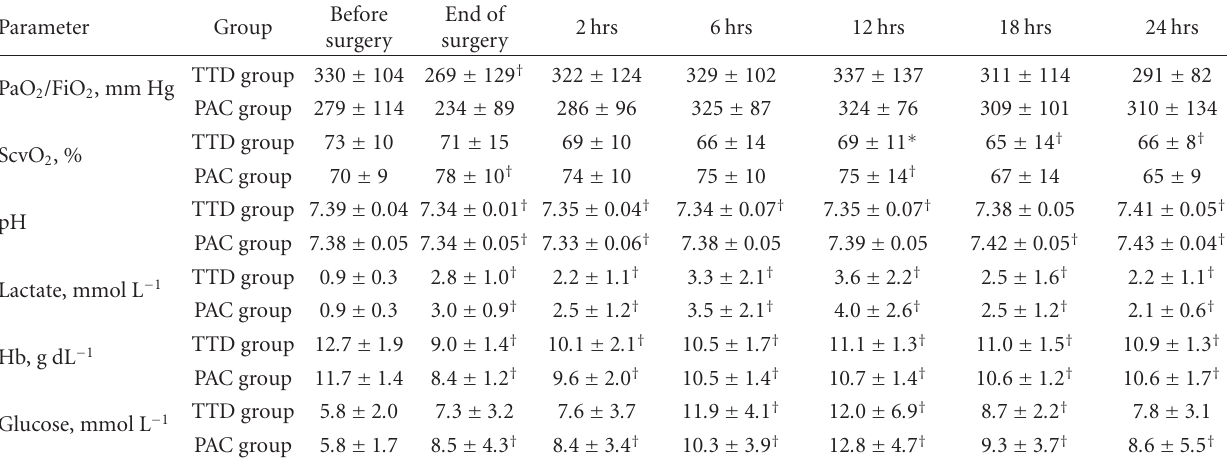
Table 3: Changes in oxygenation and laboratory parameters in the study